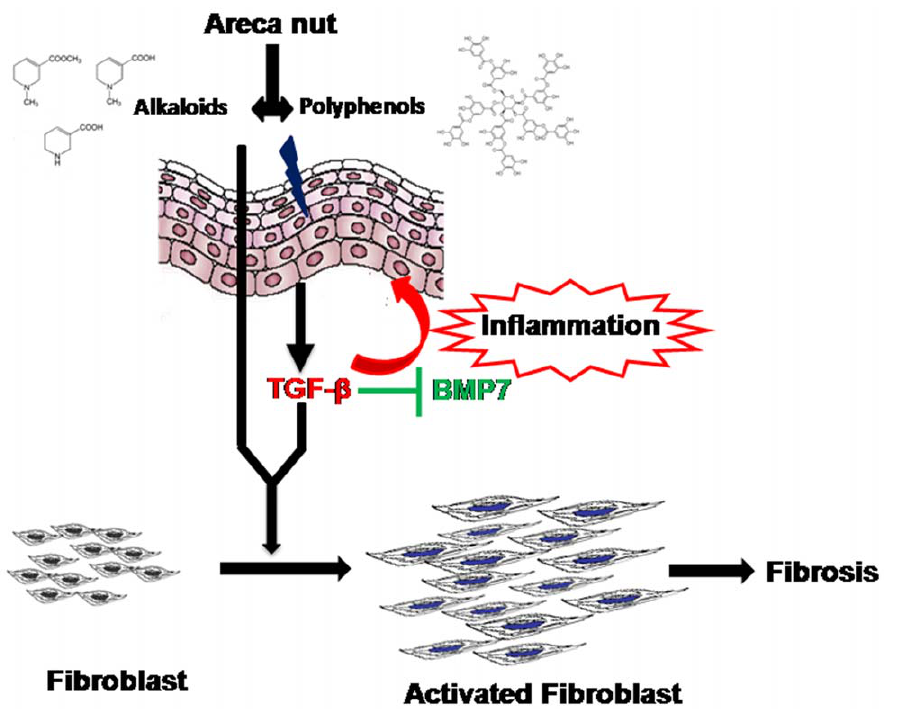
Figure 6. Diagrammatic representation of proposed model of OSF pathogenesis by areca nut and its constituents. Areca nut first comes in contact with epithelial cells where it’s both the constituent, alkaloids and polyphenols acts on the epithelial cells and induces TGF- b signaling. This induced TGF- b signaling in the epithelial cells could be source of inflammation and can also diffuse into the connective tissue where it suppresses anti-fibrogenic cytokines like BMP7. In the connective tissue, areca nut acts on fibroblast cells along with TGF- b produced from the epithelium and potentiates its action in activating fibroblast cells responsible for inducing fibrosis.